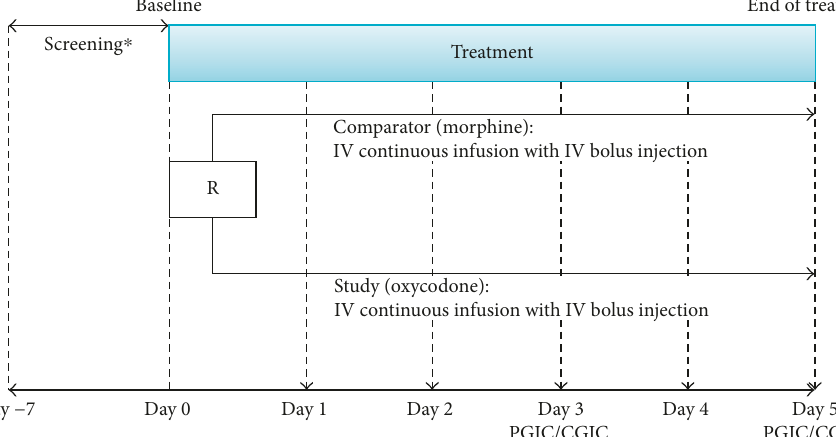
Figure 1: Study design and visit schedule. At screening, patients can be randomized if average pain intensity NRS score during previous 7 4. IV (cid:30) intravenous, NRS (cid:30) Numerical Rating Scale (0–10 points, 0 (cid:30) no pain and 10 (cid:30) worst pain), PGIC/CGIC (cid:30) Patient Global ∗ Impression of Change/Clinical Global Impression of Change, R (cid:30) ≥